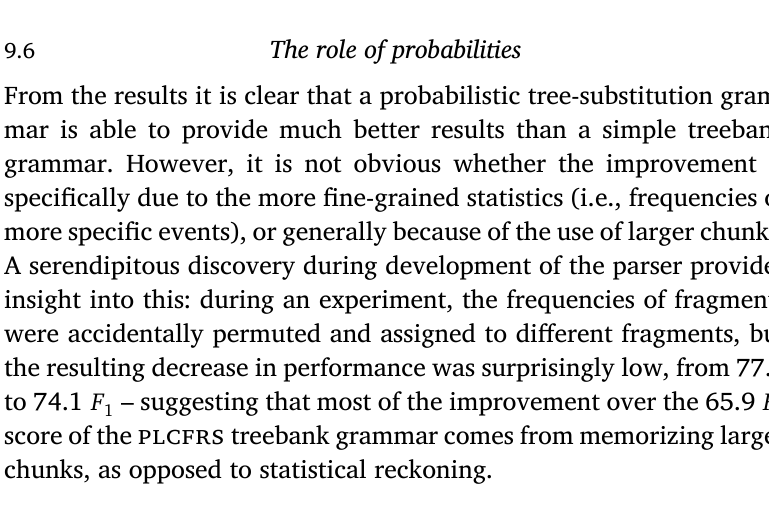
Parsing discontinuous constituents is possible without lcfrs (Negra development set, gold standard pos tags; results are for final